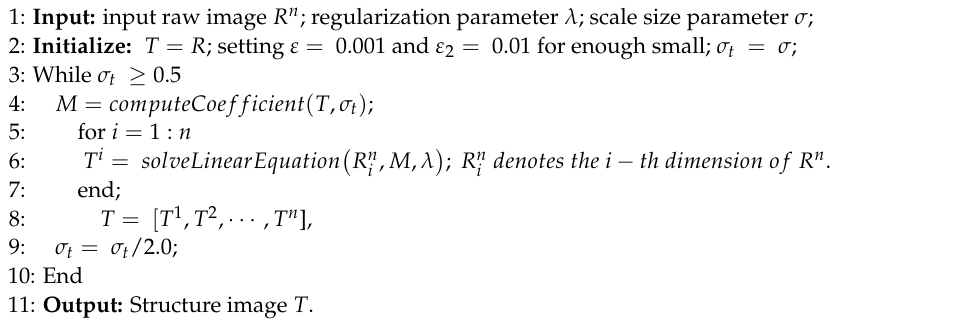
Algorithm 1: The ATVM under Numerical Solution to Extract Different Scale